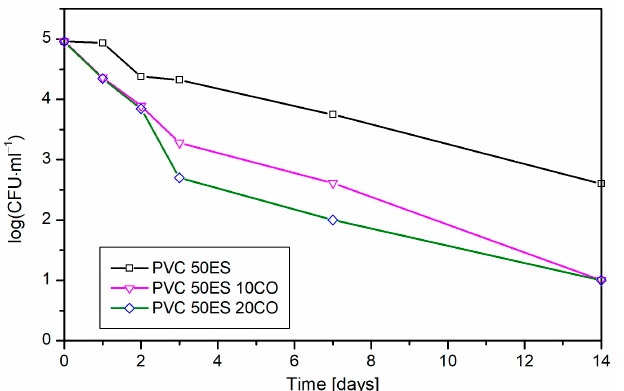
Figure 12. Influence of cassia oil concentration in PVC material on the growth of E. faecalis present on a spinach